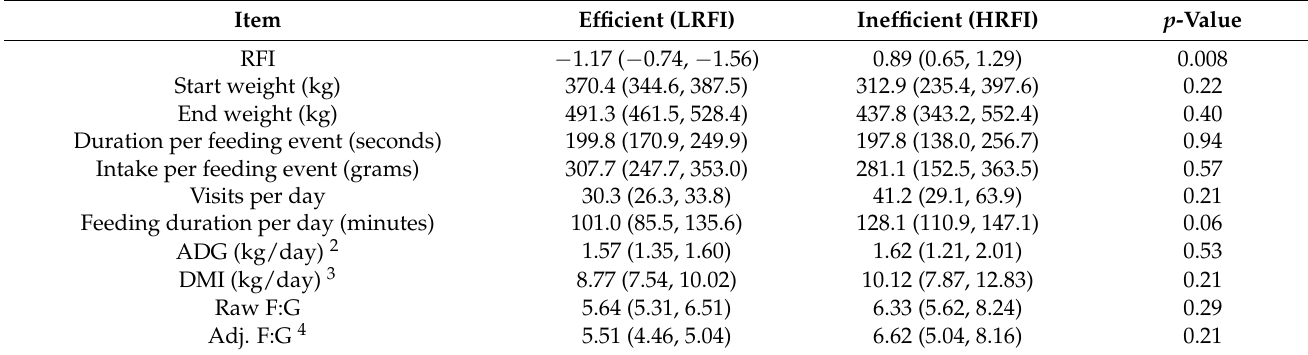
Table 1. Descriptive statistics for productive parameters for LRFI and HRFI 1 .